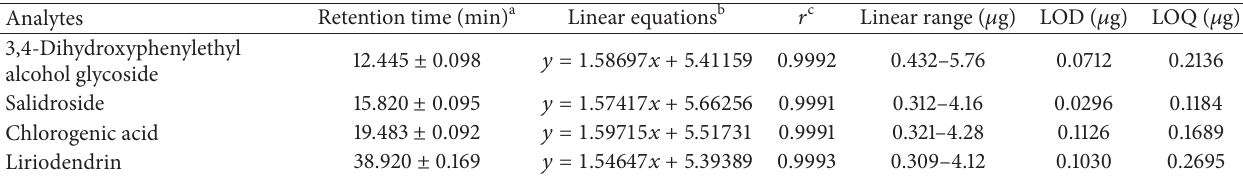
Table 1: Linear equations, linear range, LOD, and LOQ for analytes.